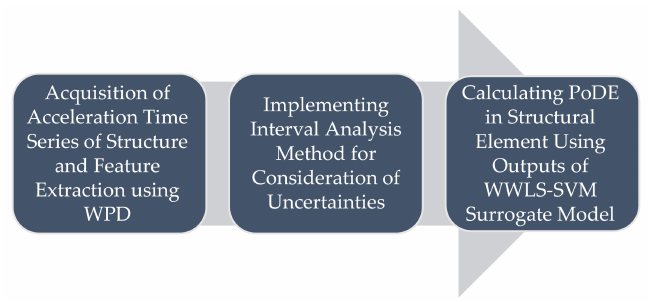
Figure 1. Summary of non-probabilistic damage detection